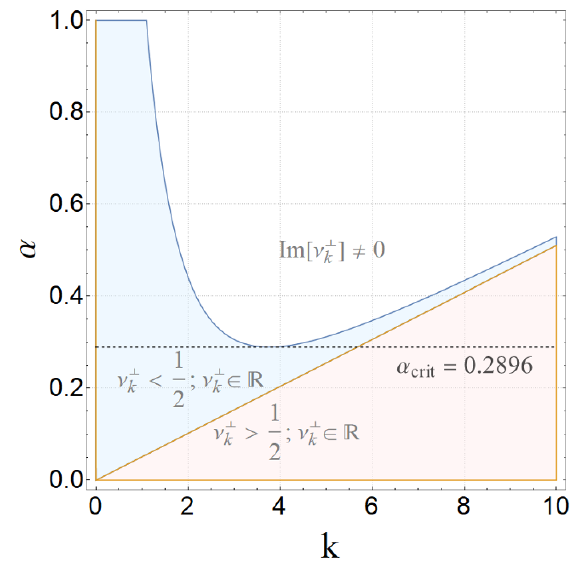
, occurring in (cid:27) k = k ] 6 = 0, represents the parameter space k